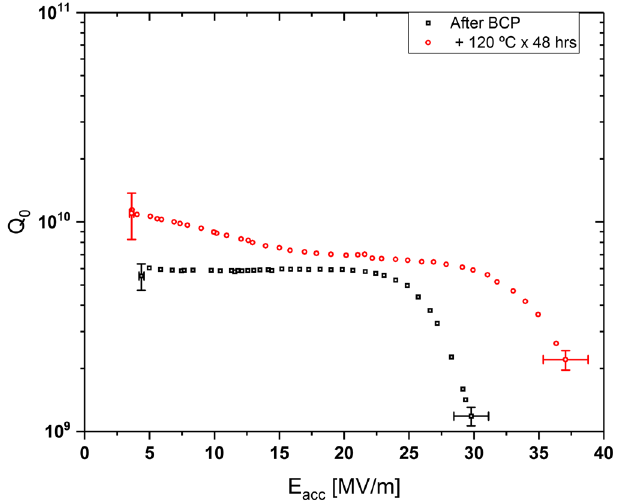
FIG. 3. FH3D test results at T b ¼ 2 . 0 K before and after baking at 120 °C for 48 hours. No radiation was observed during the